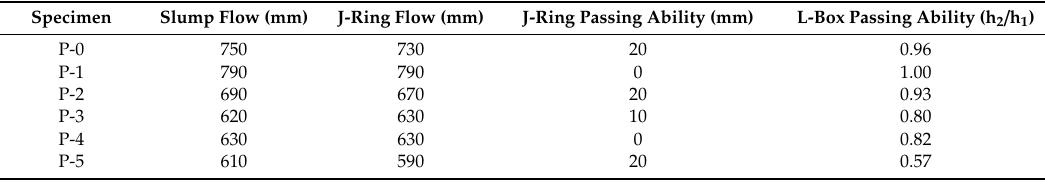
Table 4. Results of flowability and self-consolidating tests of TiO 2 -incorporated UHPC.